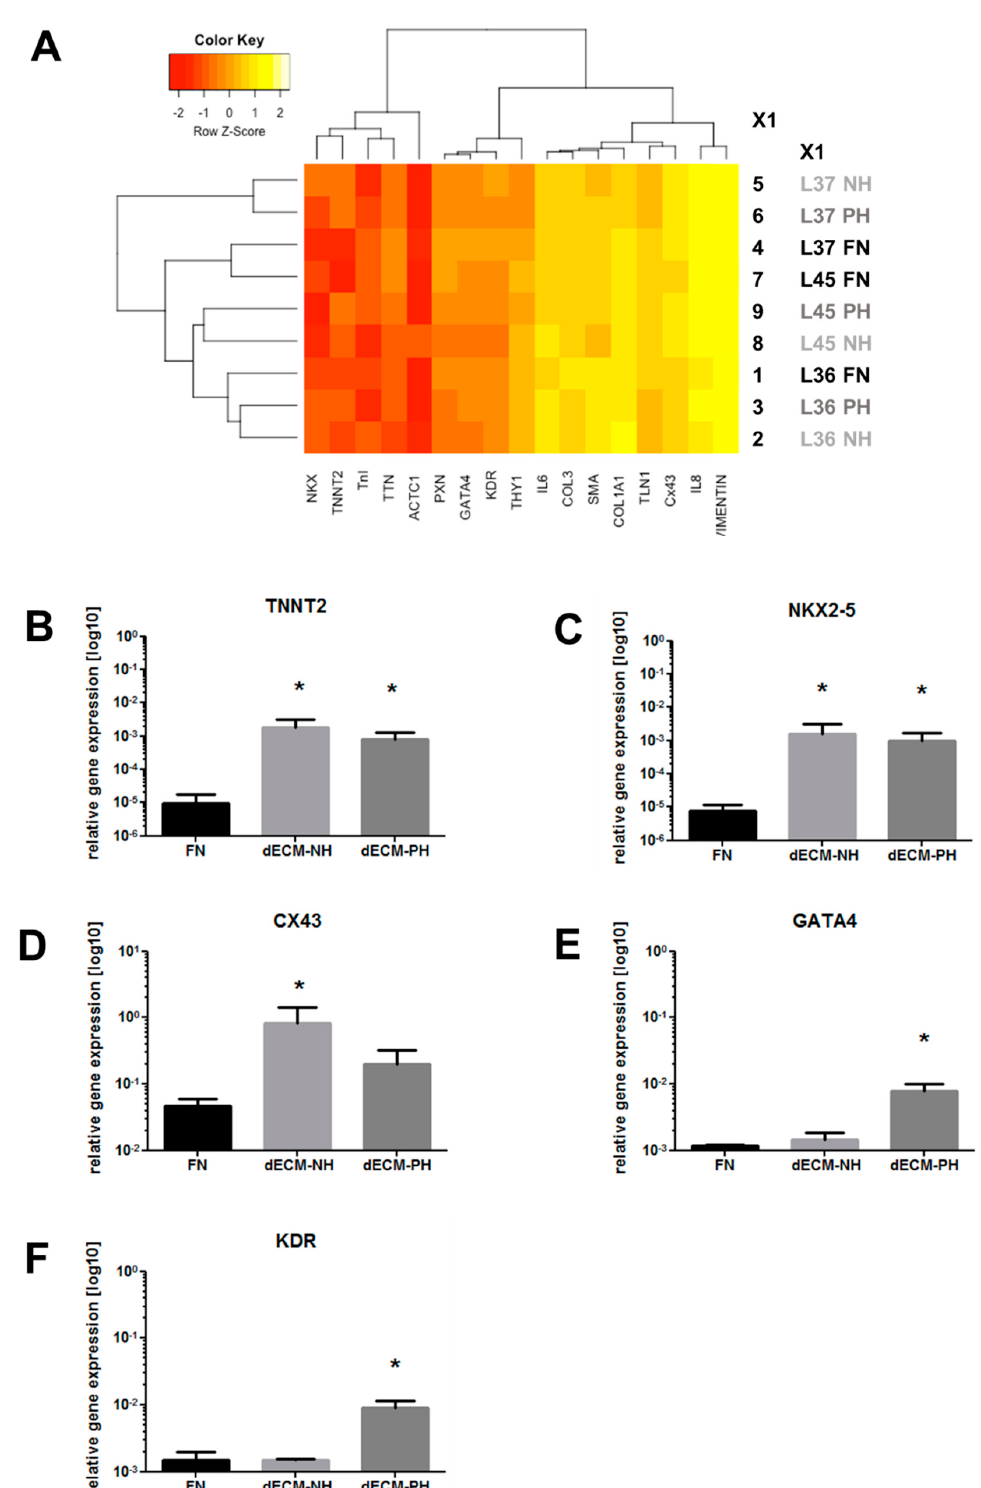
Figure2. GeneexpressionanalysisofCPCsseededondi ff erentsubstrates. ( A )Heatmapandhierarchical clustering analysis of the complete panel of genes analyzed by real-time PCR. Single gene analysis was then performed for the expression levels of significantly modulated genes, that is, troponin T (TNNT2) ( B ), NK2 Homeobox 5 (NKX2-5) ( C ), connexin 43 (CX43) ( D ), GATA4 ( E ), and kinase insert domain receptor (KDR / VEGFR2) ( F ), in CPCs cultured on fibronectin coating (FN), or on decellularized extracellular matrix (dECM) from normal hearts (NH) or pathological hearts (PH). n = 3–6. *: p < 0.05 vs.